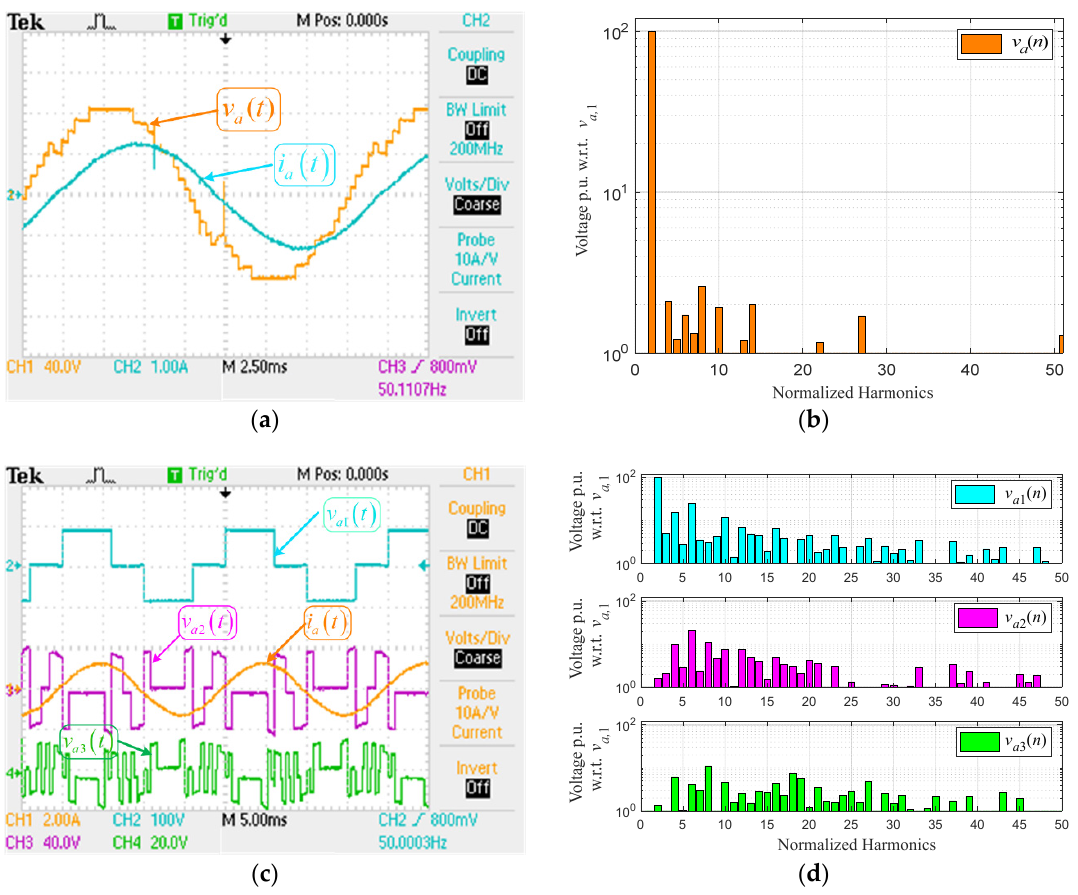
Figure 13. Experimental key waveforms for m = 0.7. ( a ) output voltage v a ( t ) and load current i a ( t ), ( b ) Harmonic spectrum for output voltage v a ( n ), ( c ) Individual inverter output voltages v ai ( t ) and load current i a ( t ), ( d ) Harmonic spectrum v a 1 ( n ), v a 2 ( n ), and v a 3 ( n ).